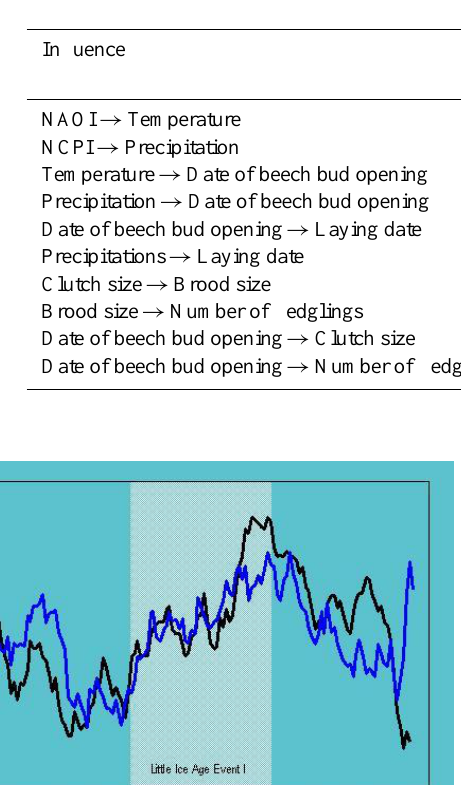
Table 4. Parameter estimates for the favoured model 14 as in Table 3. N = 73yr.